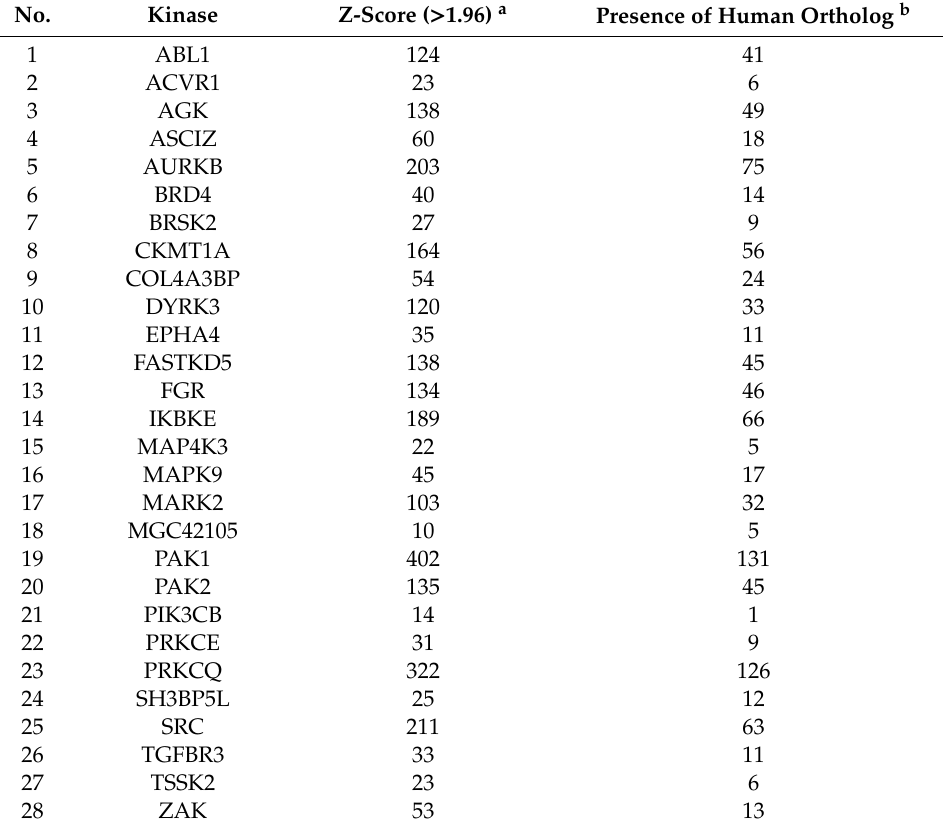
Table 3. The number of genetic interaction partners for each